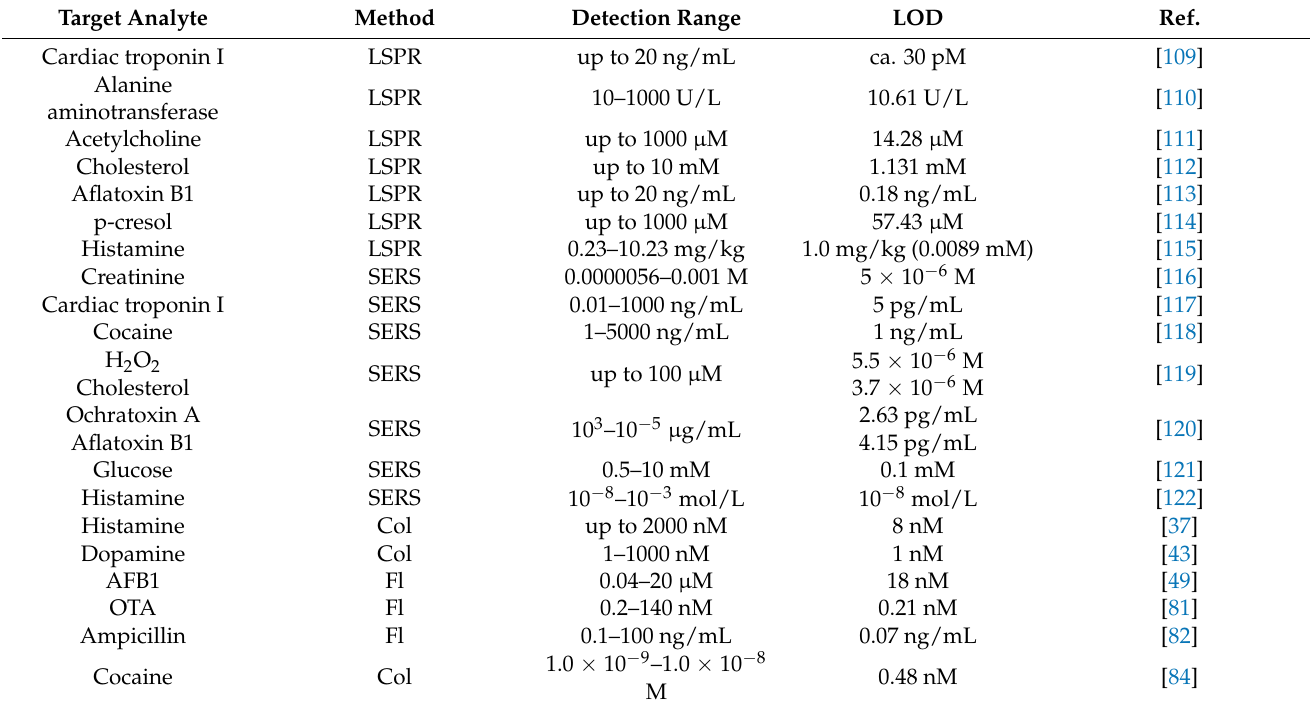
Table 2. Summary of biomolecular detections based on LSPR and